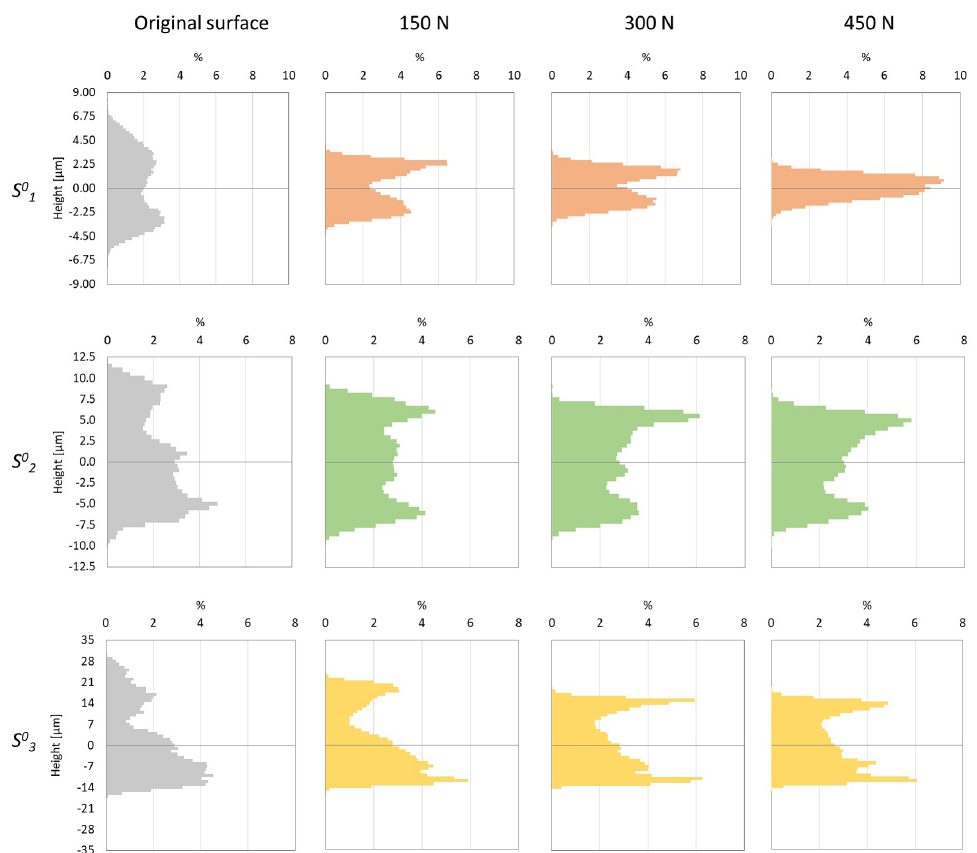
Figure 8. Evolution of height distribution histograms for all tests with five passes.